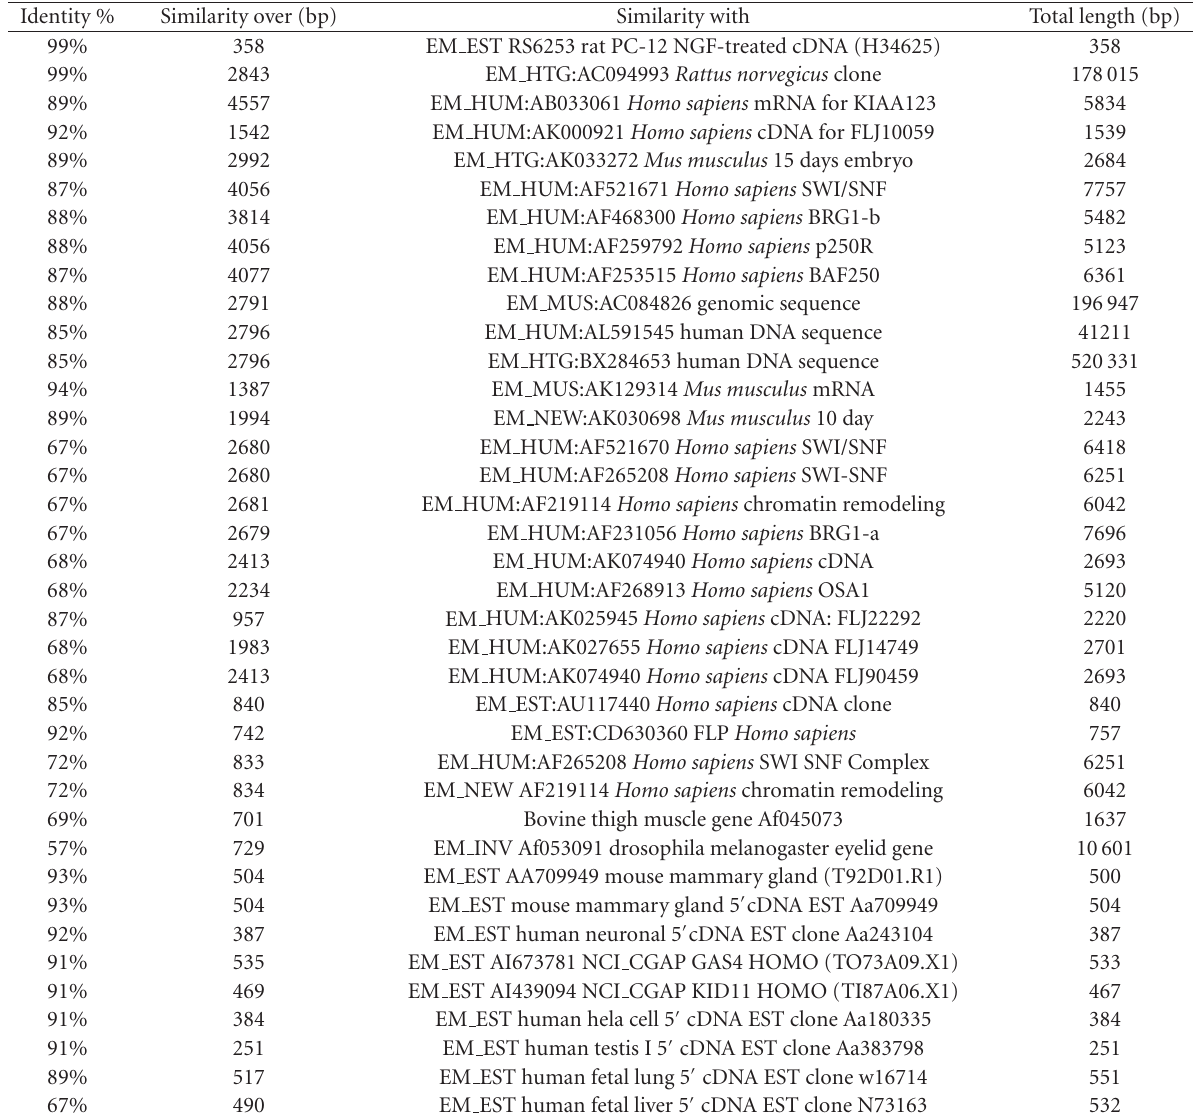
Table 2. Similarities of rat 6A3-5 gene with nucleotide sequences in the databases. After comparison to all databases, 6A3-5 had similarities mainly to human EST clones (established sequence tags). One interesting EST sequence was the rat PC-12 EST clone. This rat EST sequence could not be obtained and amplified. Another interesting EST clone was KIAA1235 which is thought to be a transcription factor expressed in the brain. The corresponding gene was estimated to be of 6.5kb. Identity % Similarity over (bp) Similarity with Total length